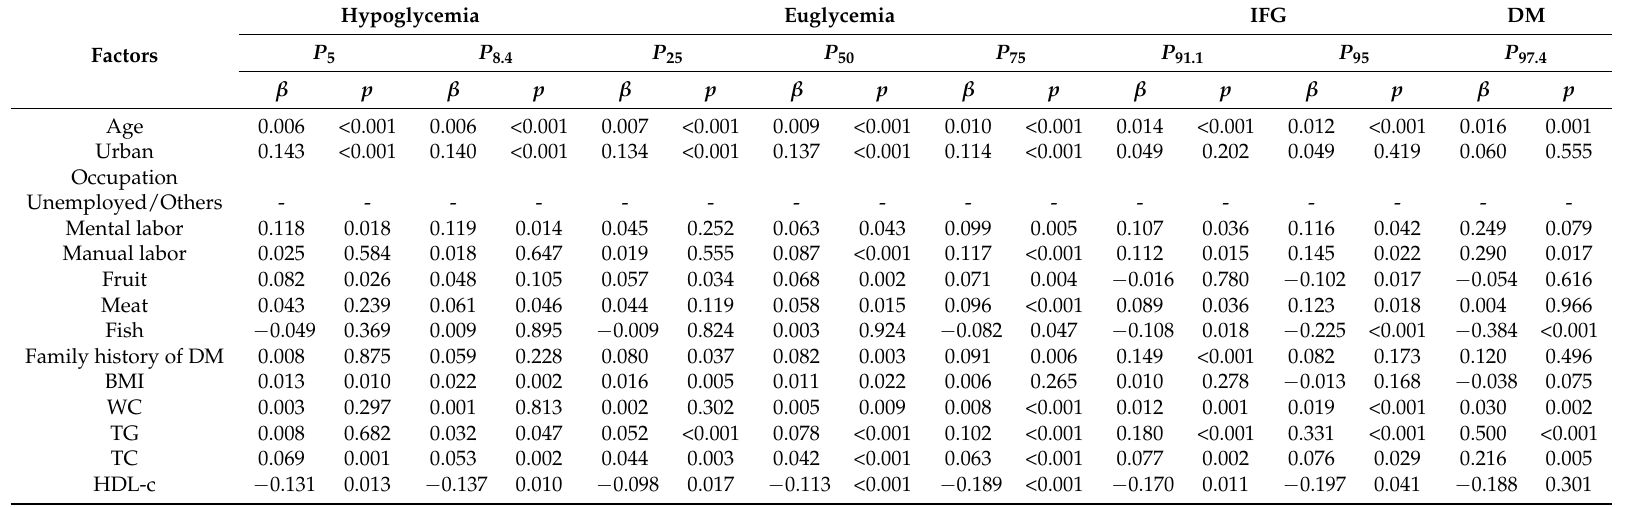
Table 3. Quantile regression coefficients between FBG and variables for